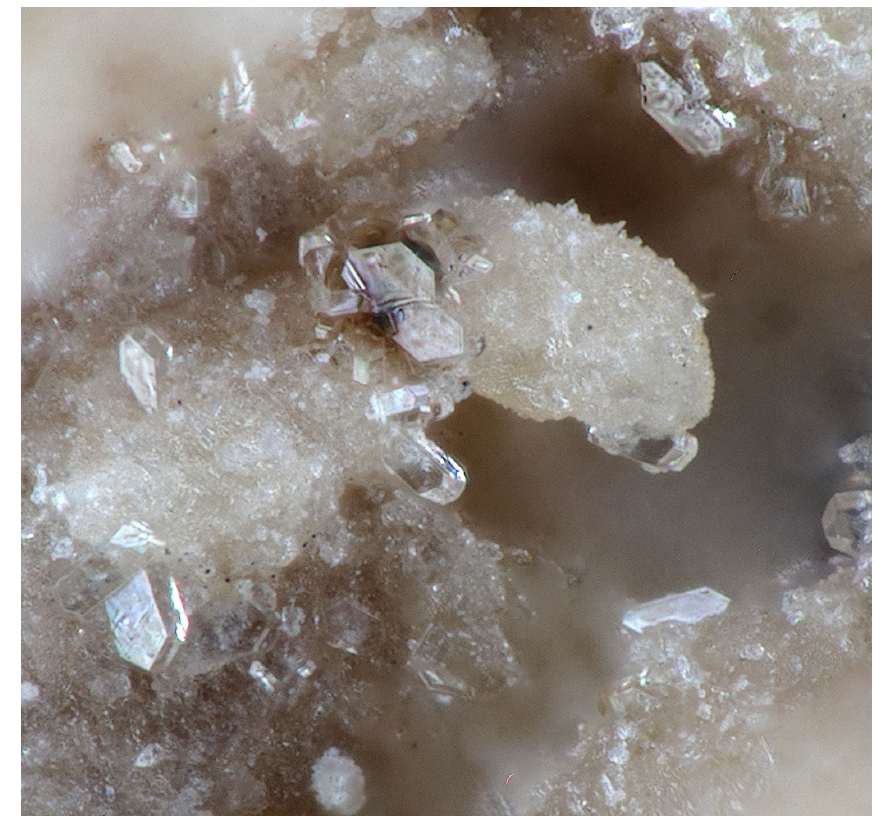
Figure 1. Pleysteinite crystals on fine-grained zwieselite. Field of view is 0.5mm. Photo by Christian Rewitzer.